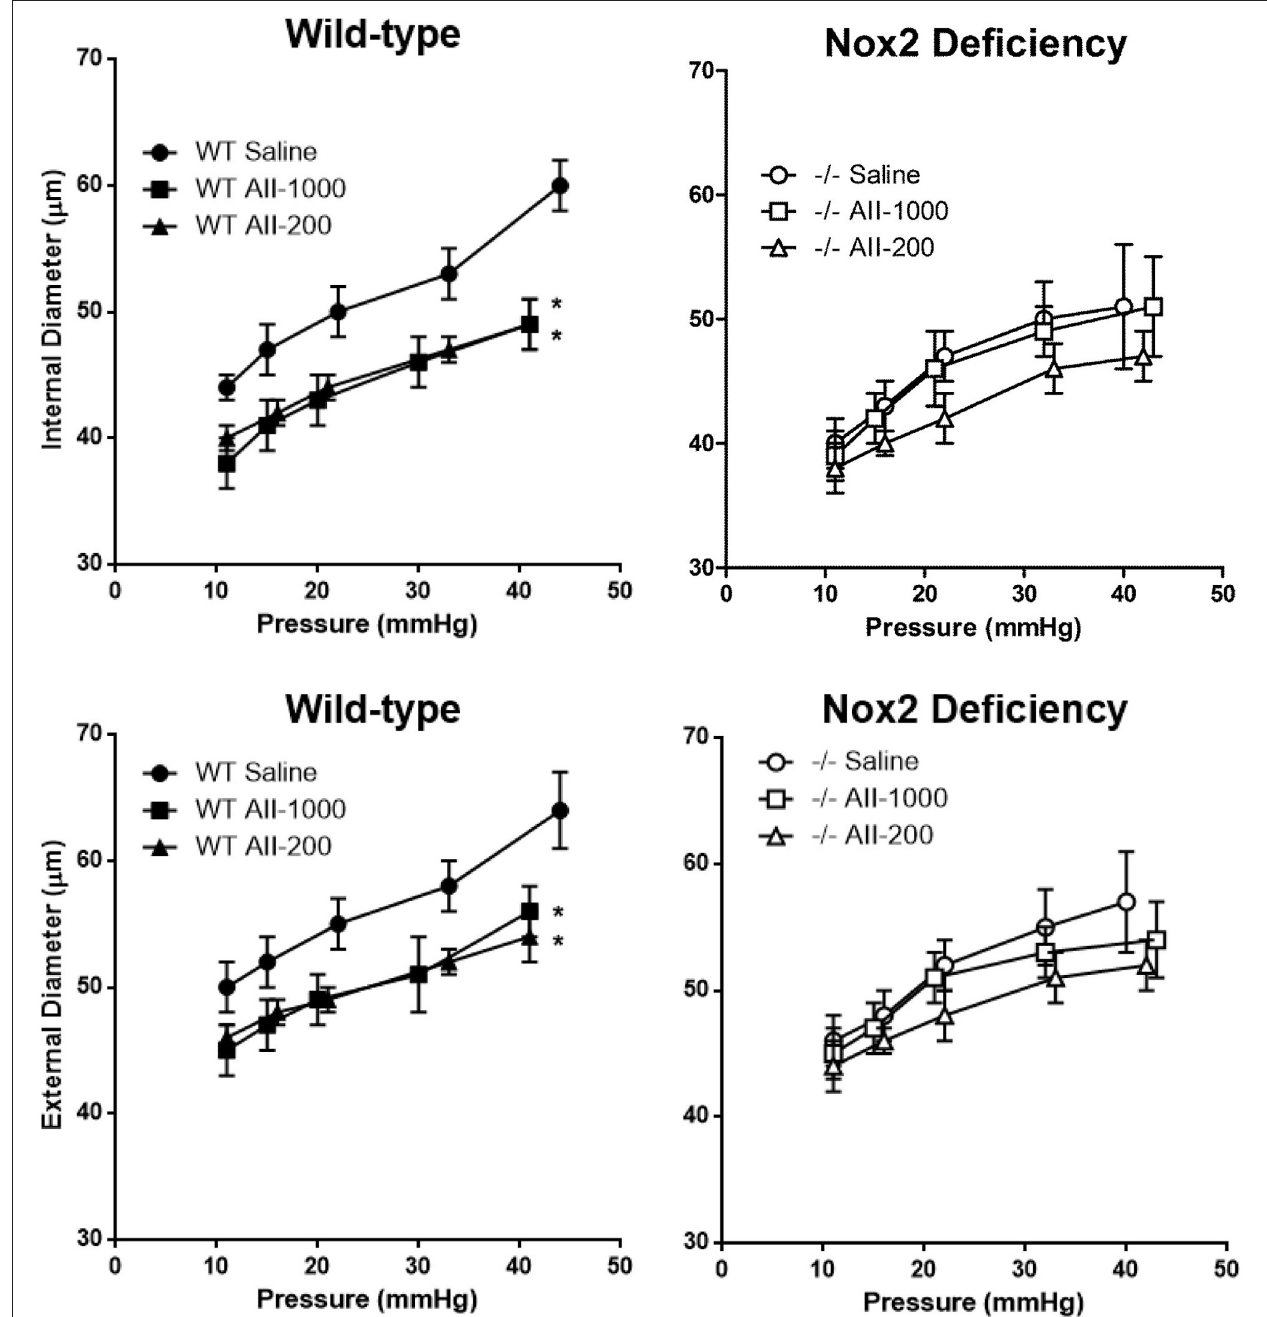
FIGURE 2 | Pressure-internal and external diameter relationships in maximally dilated cerebral arterioles in wild-type (WT) or Nox2-deficient ( − / − ) mice treated with a pressor (AII-1000) or